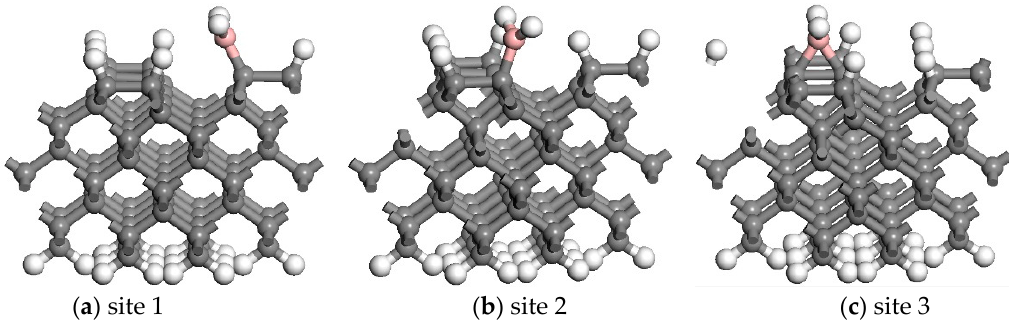
Figure 6. The optimization structure of diamond when BH 2 is adsorbed on diamond (100) surface before the CH 3 adsorption.